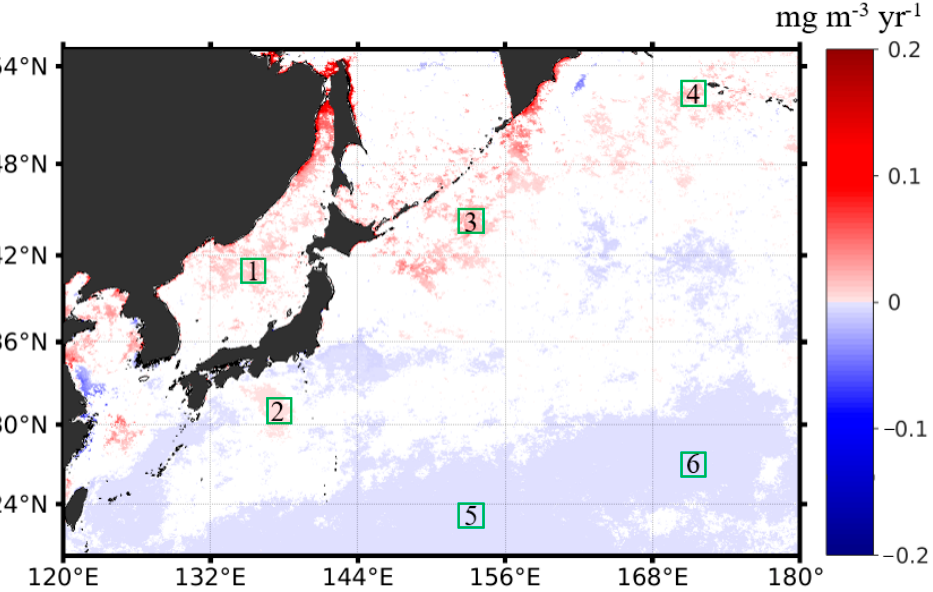
Figure 5. The spatial distribution of the interannual changing rates (unit: mg m − 3 yr − 1 ) of Chl-a in the northwest Pacific, based on the monthly Chl-a anomalies in the period of 1997–2020, with warm colors suggesting a Chl-a increase (i.e., positive trends) and cold colors suggesting a Chl-a decrease (i.e., negative trends). Note that only data that passed the confident tests ( p < 0.05) were shown; the areas in white mean that the Chl-a had no significant interannual trends in the study period. The six subregions outlined in a 2° × 2° box (i.e., boxes of 1–6 outlined in green) were selected for further investigation of the contrasting Chl-a interannual dynamics (i.e., positive vs. negative trends).